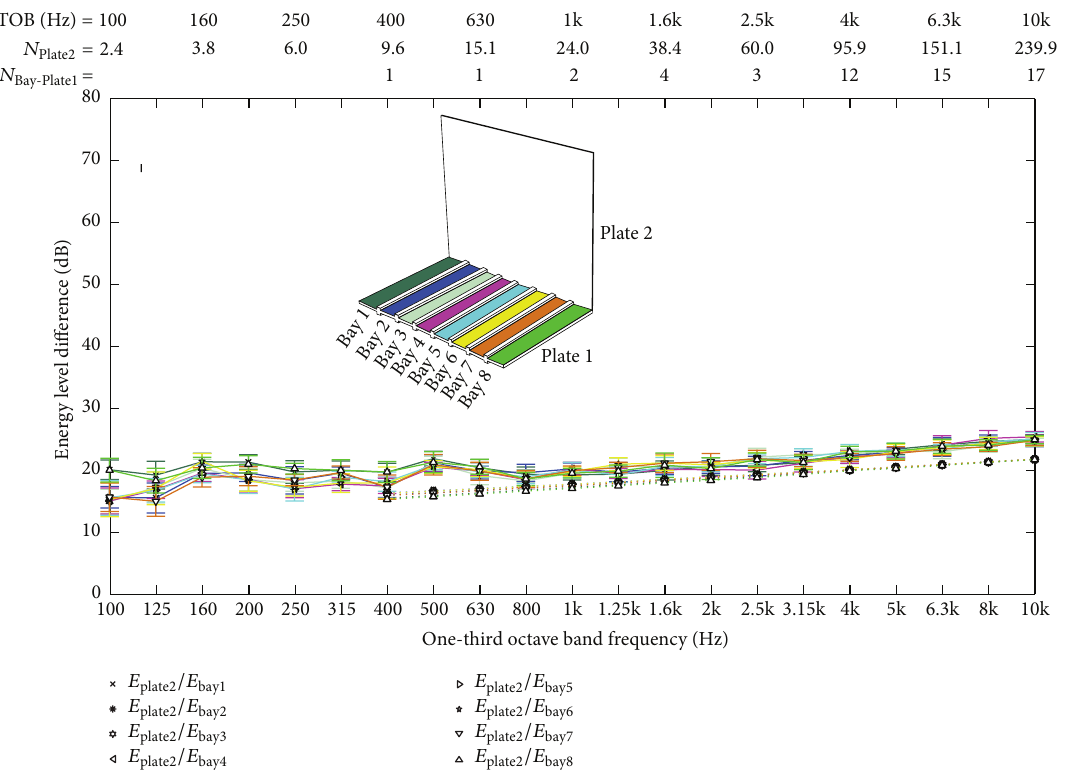
Figure 11: L-junction C. Excitation: Plate 2. Energy level differences between the isotropic plate (Plate 2) and each of the bays that form the other periodic ribbed plate (Plate 1). Comparison between FEM and ASEA (FEM data are shown using markers with continuous lines; ASEA data are shown using markers with dotted lines). Upper 𝑥 -axis indicates the mode counts for each bay of the ribbed plate ( 𝑁 2 ( 𝑁 Plate2